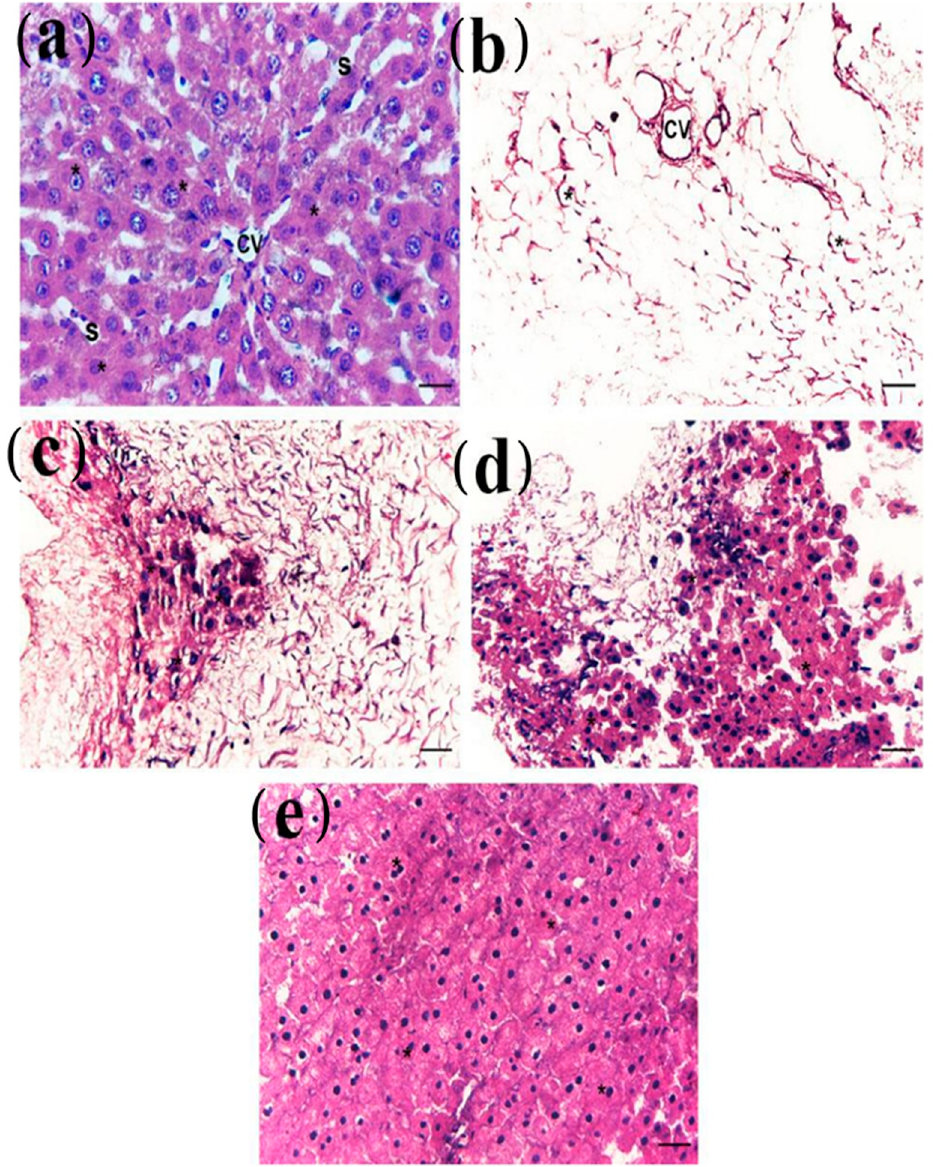
Figure 5. Photomicrograph of a section in normal liver, decellularized scaffolds as well as recellular- ized scaffold 4, 14, and 24 days after iPSCs cell seeding showed ( a ): group I (control group) showed cords of normal hepatocytes radiating from a central vein (CV), hepatocytes (*) are cubical with a large central basophilic nucleus and blood sinusoids (S); ( b ): group II (decellularized group) showed no visible cell nuclei and cellular material (*) in all decellularized livers; ( c ): group IIIa (recellularized group after 4 days): showed a minimal distribution of cellular engraftment (*) across the scaffold at day 4; ( d ): group IIIb (recellularized group after two weeks): showed a moderate distribution of cellular engraftment (*) across the scaffold at day 14; ( e ): group IIIc (recellularized group after 24 days): showed complete cell sheets (*) forming colonies resembling hepato- cytes.